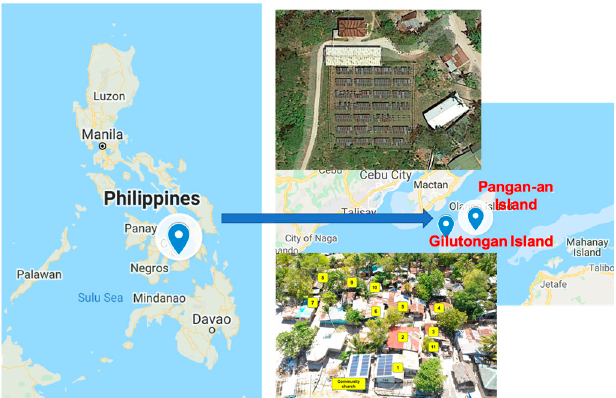
Figure 1. Pangan-an and Gilutongan Islands, Philippines (Image courtesy of Google maps). Gilutongan Island (10 ◦ 12 (cid:48) 00” N, 123 ◦ 59 (cid:48) 00” E), an island barangay in Cordova,